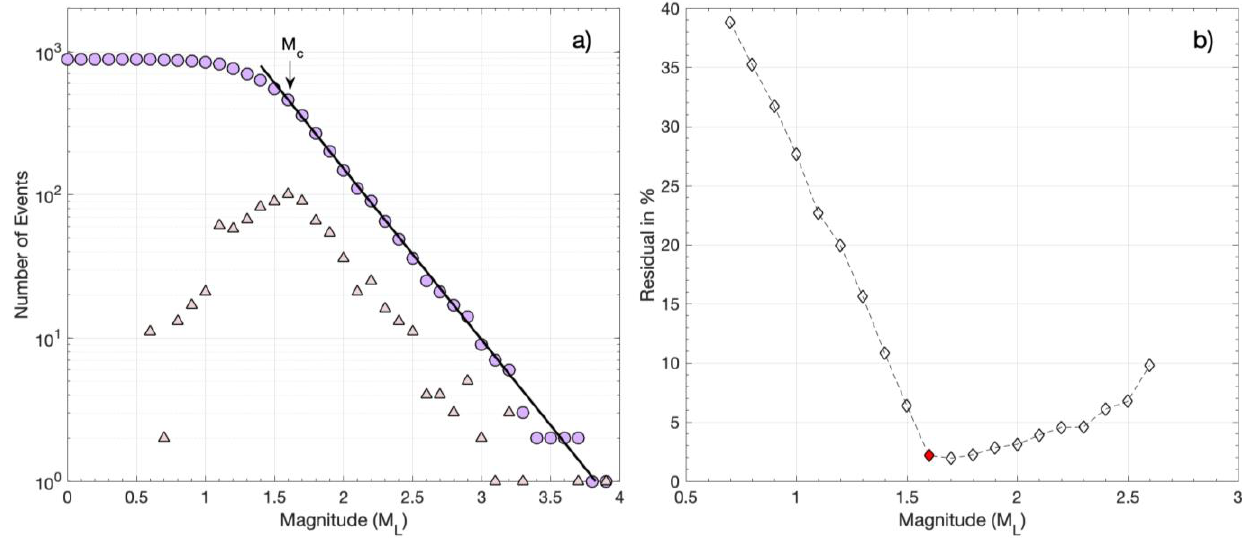
Figure 4. ( a ) Cumulative (filled circles) and discrete (filled triangles) frequency – magnitude distribution for CAT1. The solid line represents the Gutenberg – Richter (G – R) scaling relation for a = 4.57 and b = 1.20. ( b ) Residual plot between the observed frequency – magnitude distribution and the fit to the G – R relation as a function of the lower magnitude cut-off. The filled red symbol represents the M c of 1.6 for 95% residuals.